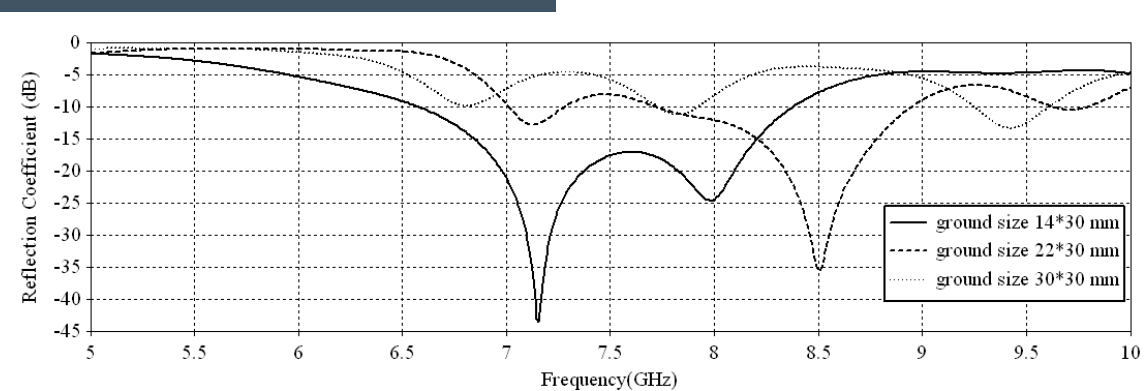
Figure 2. Effect of varying ground dimensions on reflection coefficient as a function of frequency